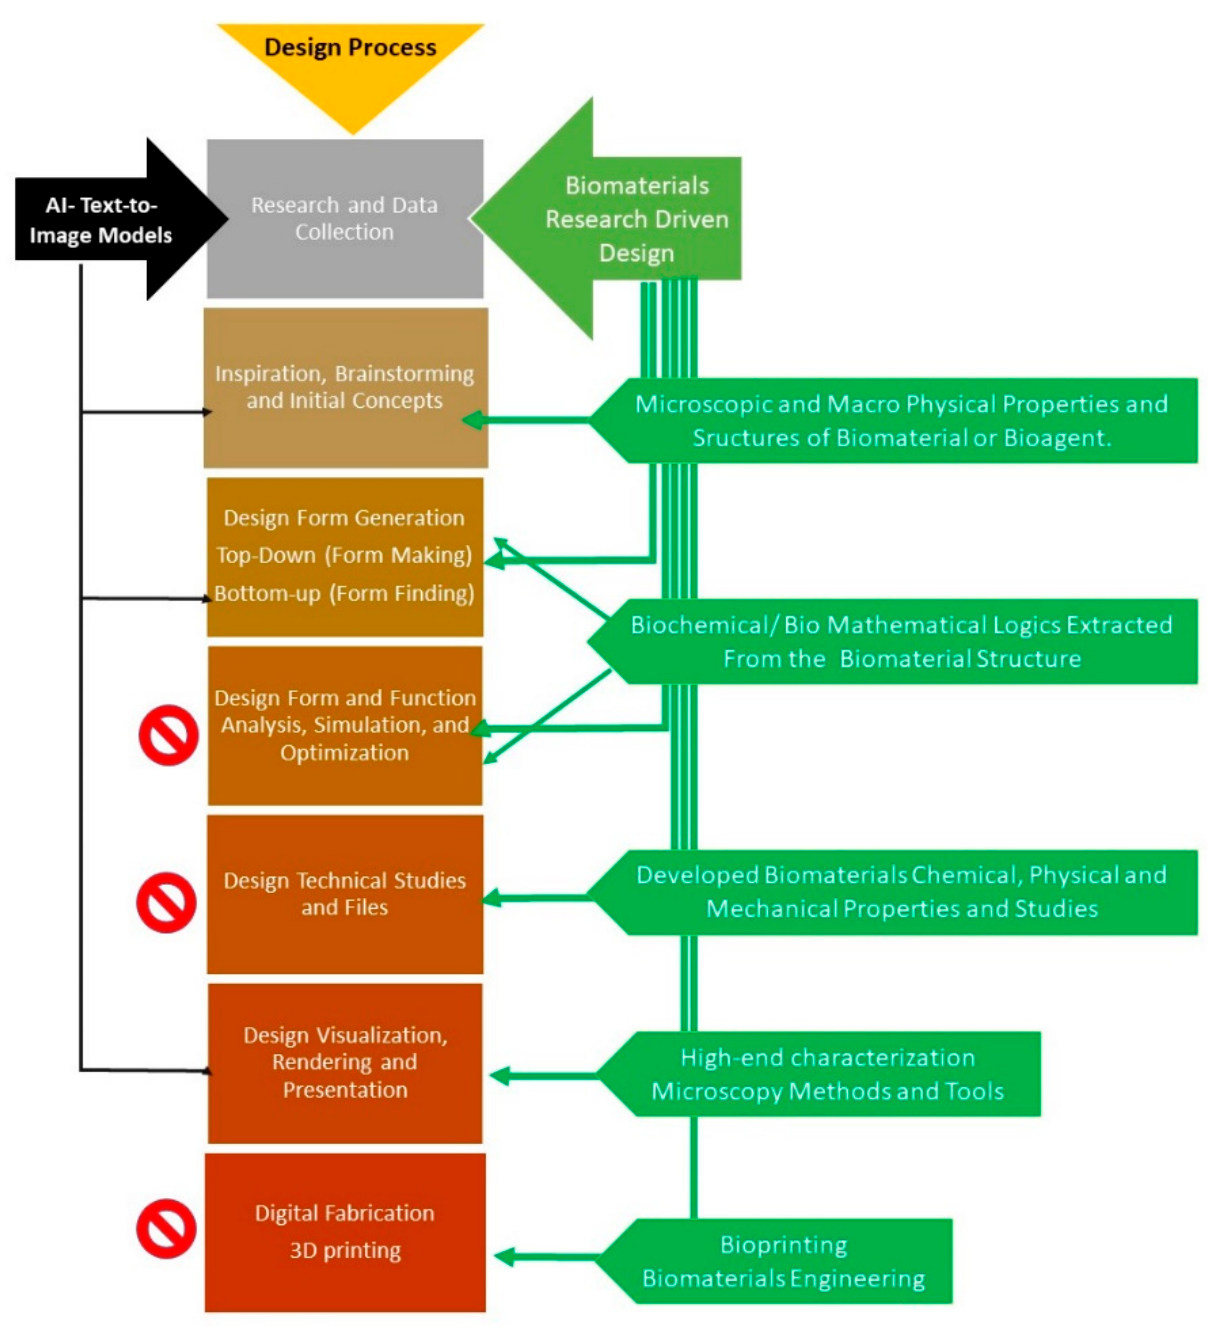
following figure (Figure 7) exhibits a diagram of the AI text-to-image models’ role in the biomaterials research-driven design process in its various phases.